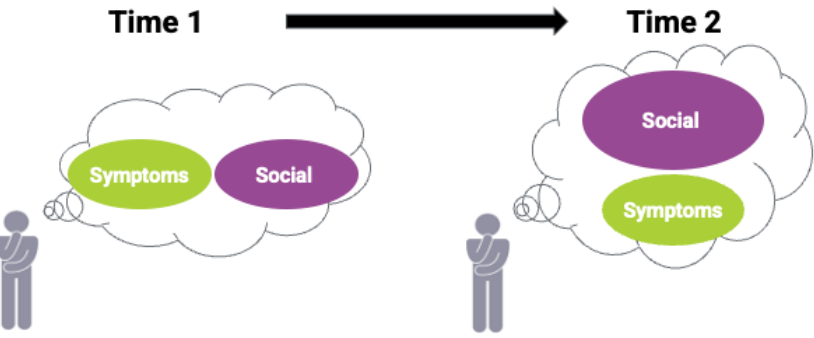
Figure 5. Bill changes which health domains matter most over time (reprioritization).